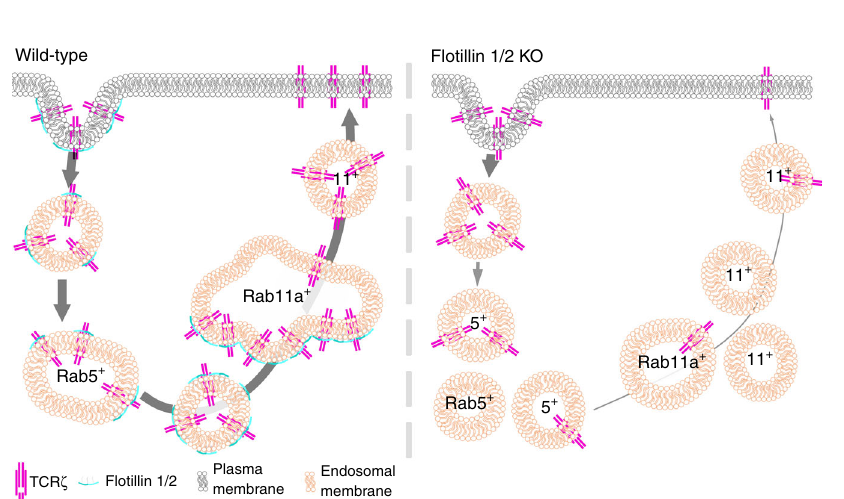
Fig. 5 Rab5 and Rab11a are critical to TCR ζ recycling. a Schematic depicting the coupling of optogenetic aggregation using CIB1/Cry2 with two-photon photoactivation. b Representative images of TCR ζ -PSCFP2 photoactivated from either mCherry-Rab11a (left) or CIB1-FugeneRed-Rab11a (right) co- expressed with mCerulean-Cry2clust following exposure to blue light for 10 frames with 30 s intervals. Two-photon photoactivation was undertaken 2.5 µ m within the cell for 10 frames, photoactivation region indicated by dashed circle. c Photoactivated TCR ζ -PSCFP2 signal over time at the plasma membrane when photoactivated from CIB1-FugeneRed-Rab11a or mCherry-Rab11a compartments when co-expressed with Cry2clust and exposed to blue light. d Mean TCR ζ -PSCFP2 signal from 900 to 1200 s timepoints when photoactivated from Cry2clust-aggregated CIB1-FugeneRed-Rab11a, normalised to mCherry- Rab11a as 100%. e Photoactivated TCR ζ -PSCFP2 vesicle number outside the initial photoactivated region over time when photoactivated from CIB1- FugeneRed-Rab11a or mCherry-Rab11a when co-expressed with Cry2clust and exposed to blue light. Image plane quanti fi ed is 1 µ m above the plasma membrane. f Representative images of TCR ζ -PSCFP2 photoactivated from either mCherry-Rab5 (left) or CIB1-FugeneRed-Rab5 (right) co-expressed with mCerulean-Cry2clust following exposure to blue light for 10 frames with 30 s intervals. Two-photon photoactivation was undertaken 2.5 µ m within the cell for 10 frames, photoactivation region indicated by dashed circle. g Photoactivated TCR ζ -PSCFP2 signal over time at the plasma membrane when photoactivated from CIB1-FugeneRed-Rab5 or mCherry-Rab5 compartments when co-expressed with Cry2clust and exposed to blue light. d Mean TCR ζ - PSCFP2 signal from 900 to 1200 s timepoints when photoactivated from Cry2clust-aggregated CIB1-FugeneRed-Rab5, normalised to mCherry-Rab5 as 100%. e Photoactivated TCR ζ -PSCFP2 vesicle number outside the initial photoactivated region over time when photoactivated from CIB1-FugeneRed-Rab5 or mCherry-Rab5 when co-expressed with Cry2clust and exposed to blue light. Image plane quanti fi ed is 1 µ m above the plasma membrane. Data points indicate means of independent experiments, error bars indicate mean ± SEM. * p < 0.05 from one sample t -test comparing values to normalised mCherry- Rab5/Rab11a mean of 100% from n = 6 biologically independent experiments (mCherry-Rab11a: 1; 1; 1; 1; 1; 1 cells, CIB1-FugeneRed-Rab11a: 1; 1; 1; 2; 1; 1 cells,